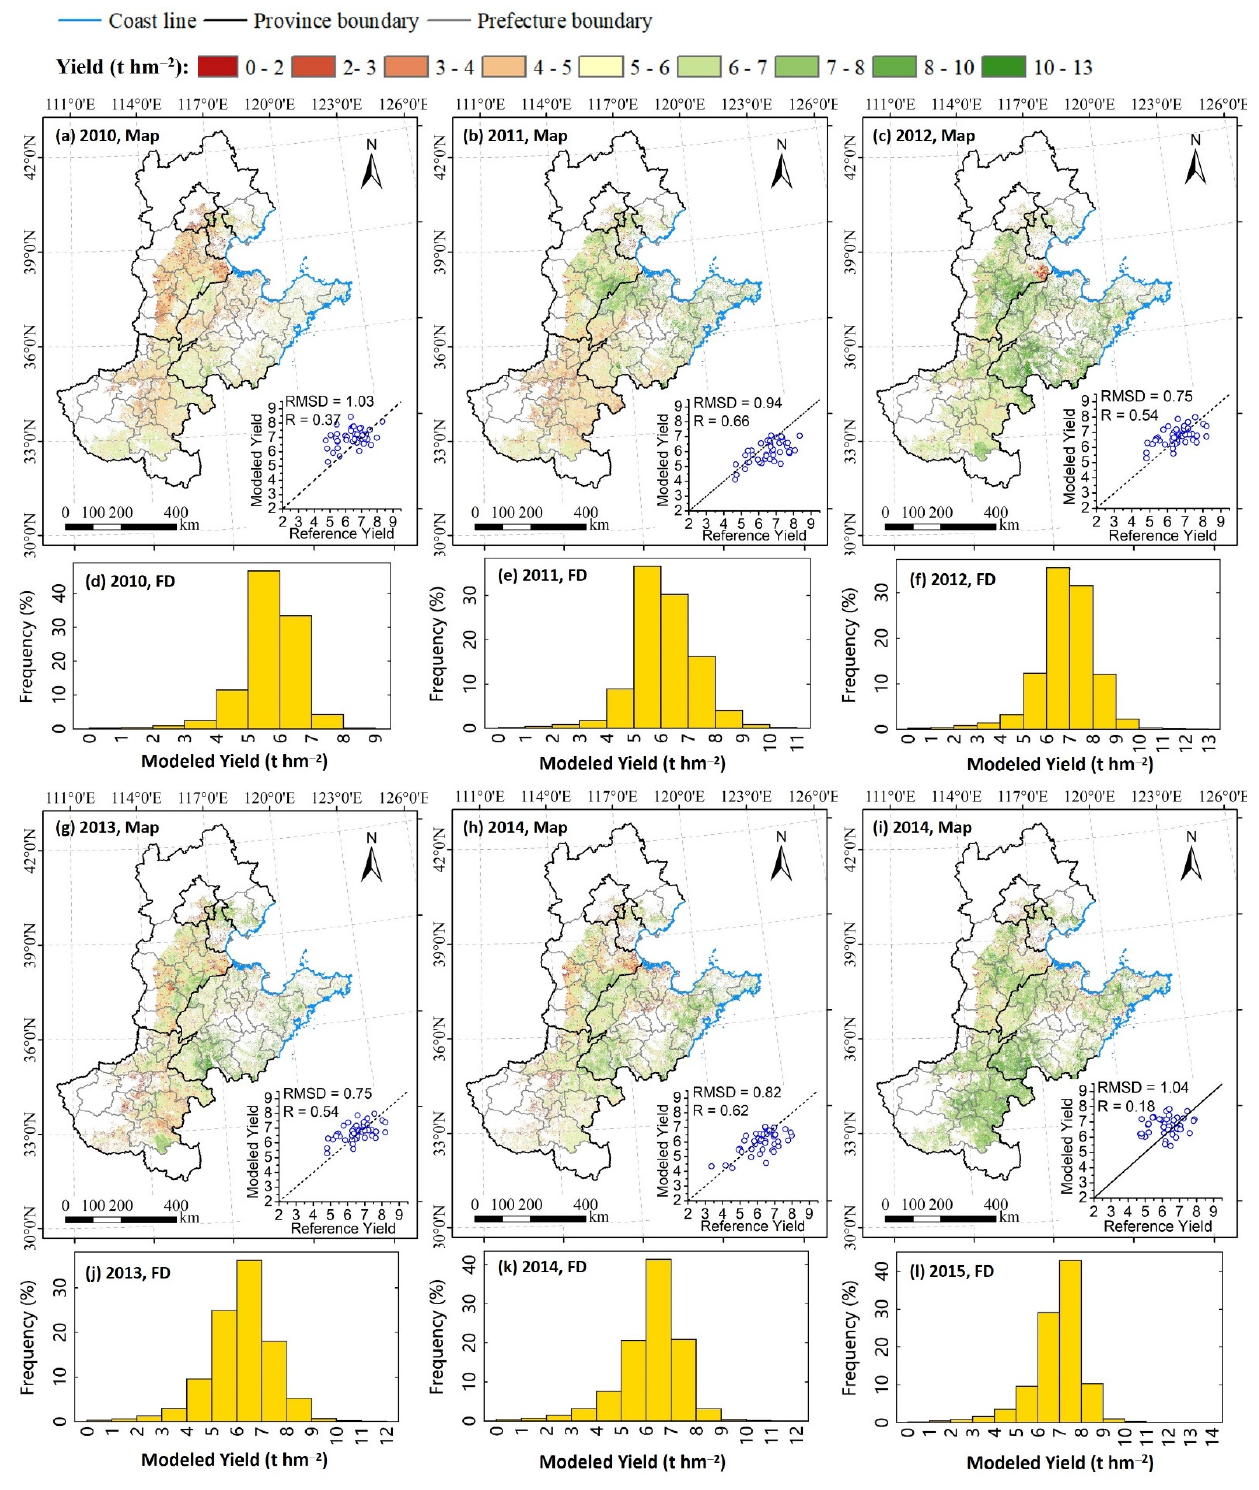
Figure 4. Maps of modeled Ya of summer maize in 2010 ( a ), 2011 ( b ), 2012 ( c ), 2013 ( g ), 2014 ( h ), and 2015 ( i ); and the pixel-level frequency distribution (FD) of pixel level values in 2010 ( d ), 2011 ( e ), 2012 ( f ), 2013 ( j ), 2014 ( k ), and 2015 ( l ). The scatter plot represents a comparison between modeled yield and reference yield on a prefecture-level, the modeled yield on a prefecture-level is the average of yield values of all pixels within a prefecture-level district, and each scatter plot has 44 samples; the solid line in each scatter plot represents the “1:1 line.” The value ranges in the legend are right-closed and